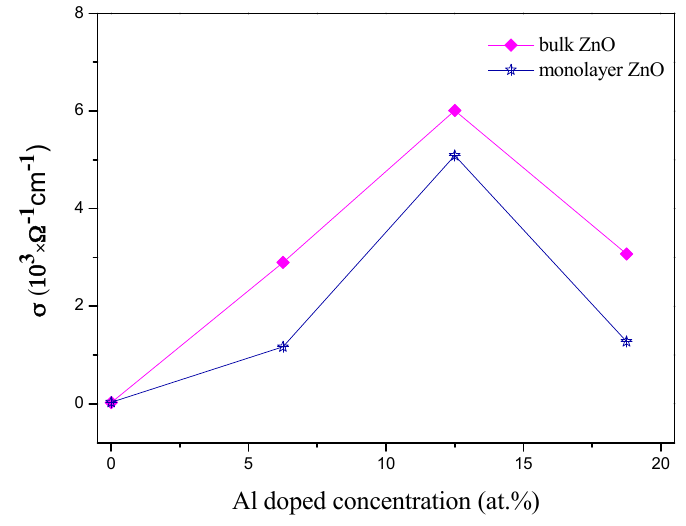
Figure 8. The electrical conductivity of ZnO bulk and monolayer doped with different Al concentrations.